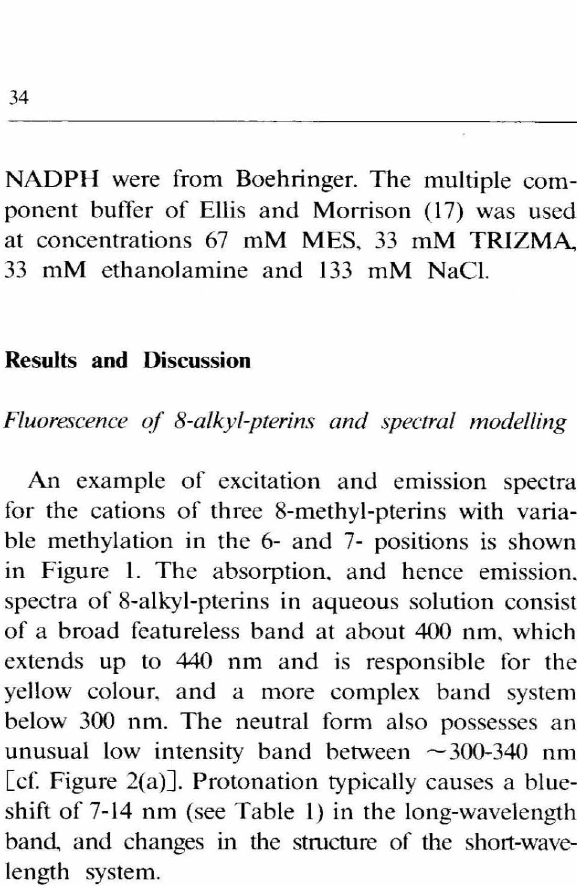
Table I. Long-wavelength excitation and emission bands of